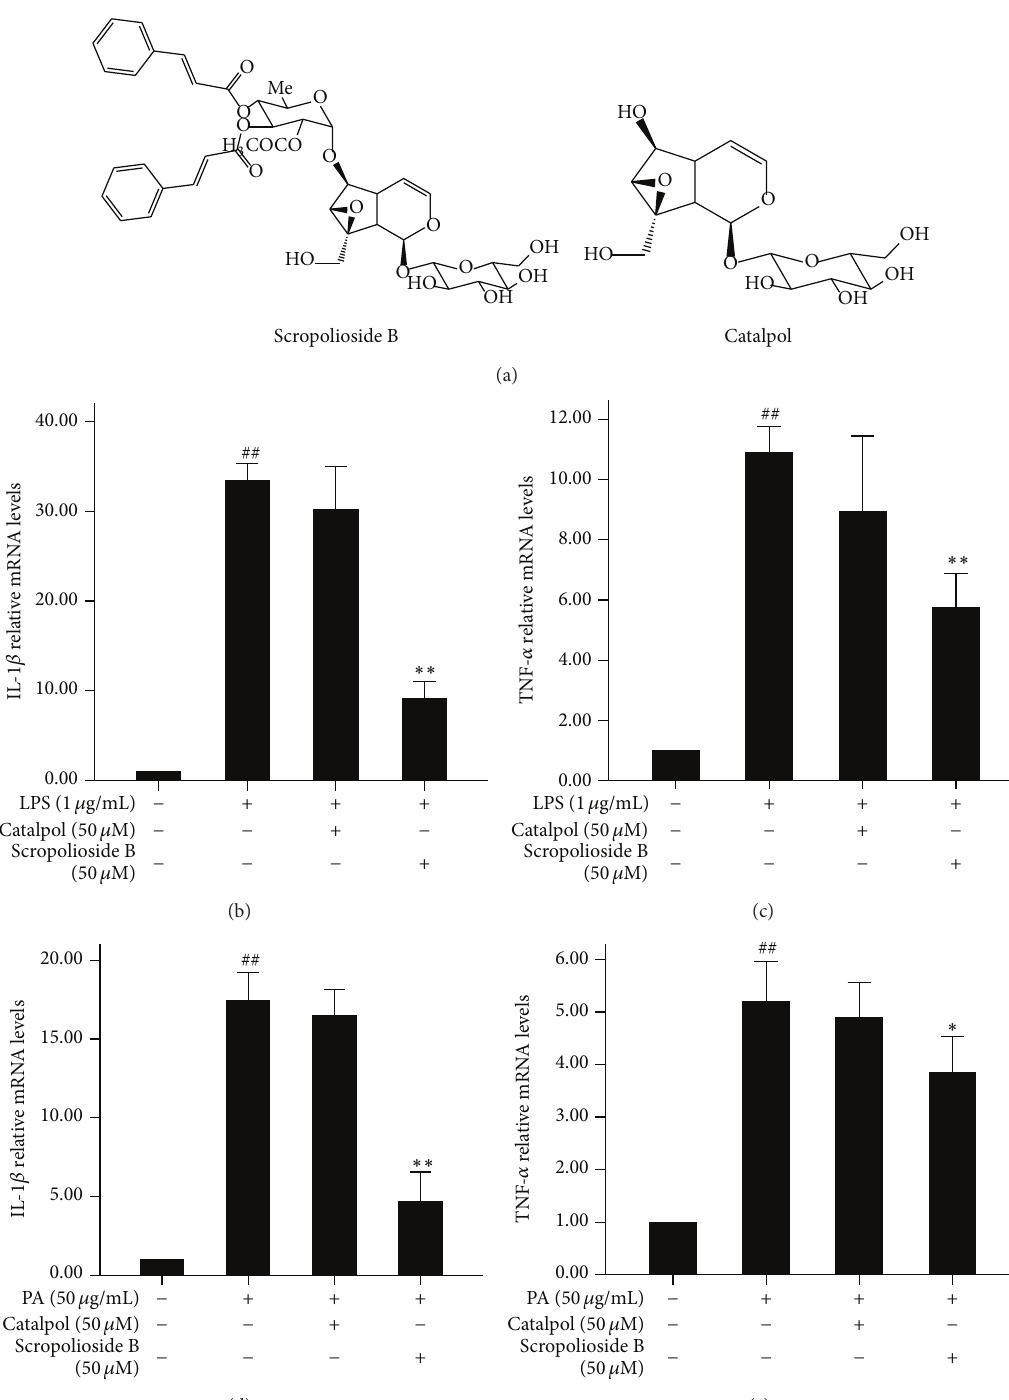
Figure 1: Different chemical structures of scropolioside B and catalpol. (a) The effects of scropolioside B and catalpol on LPS-induced expression of IL-1 𝛽 and TNF- 𝛼 in THP-1 cells. THP-1 cells were pretreated with 50 𝜇 mol/L catalpol or scropolioside B for 1h and then stimulated with LPS (1 𝜇 g/mL) for another 24 h. ((b)-(c)) The effects of scropolioside B and catalpol on PA-induced expression of IL-1 𝛽 and TNF- 𝛼 in THP-1 cells. THP-1 cells were pretreated with 50 𝜇 mol/L catalpol or scropolioside B for 1h and then stimulated with PA (50 𝜇 g/mL) for another 24 h. ((d)-(e)) The expression of IL-1 𝛽 and TNF- 𝛼 mRNA was measured by RT-PCR. The data represent the mean values of over three experiments ± SD. ## 𝑃 < 0.01 compared to vehicle control, ∗∗ 𝑃 < 0.01 compared to LPS or PA alone. # 𝑃 < 0.05 compared to vehicle control, ∗ 𝑃 < 0.05 compared to LPS or PA